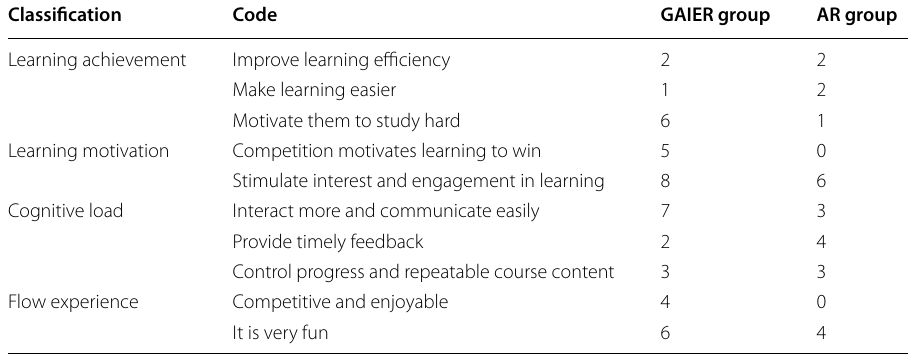
Table 9 Coding items and number of occurrences of the interview results